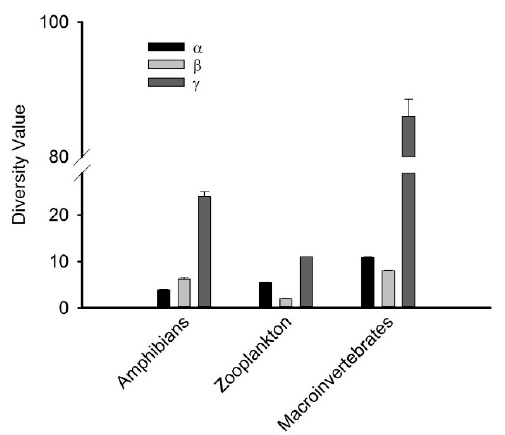
Figure 2. Diversity partitioning for amphibians, zooplankton, and macroinvertebrates. Alpha diversity is the average diversity of a single ephemeral wetland, beta diversity is the number of species turnover between wetlands, and gamma diversity the total amount of diversity present in the study for a taxonomic group. Gamma diversity is mathematically related to beta and alpha diversity γ = α × β . Error bars are ± SE.